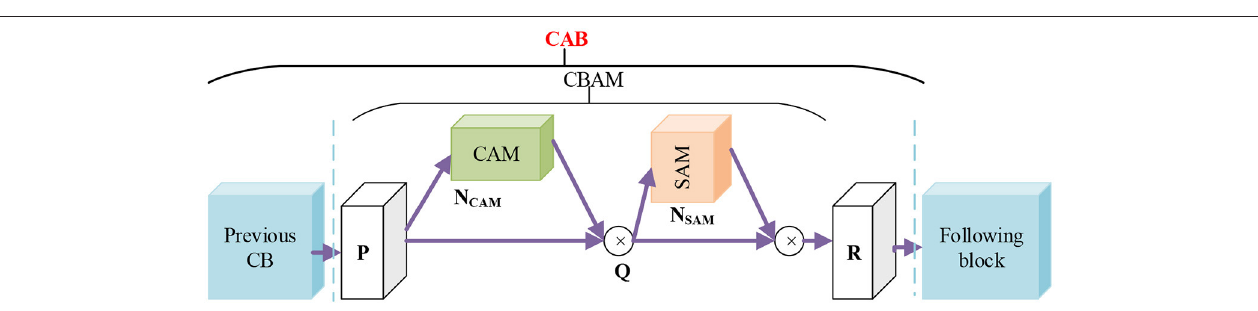
FIGURE 9 | Relationship among CAB, CBAM, and